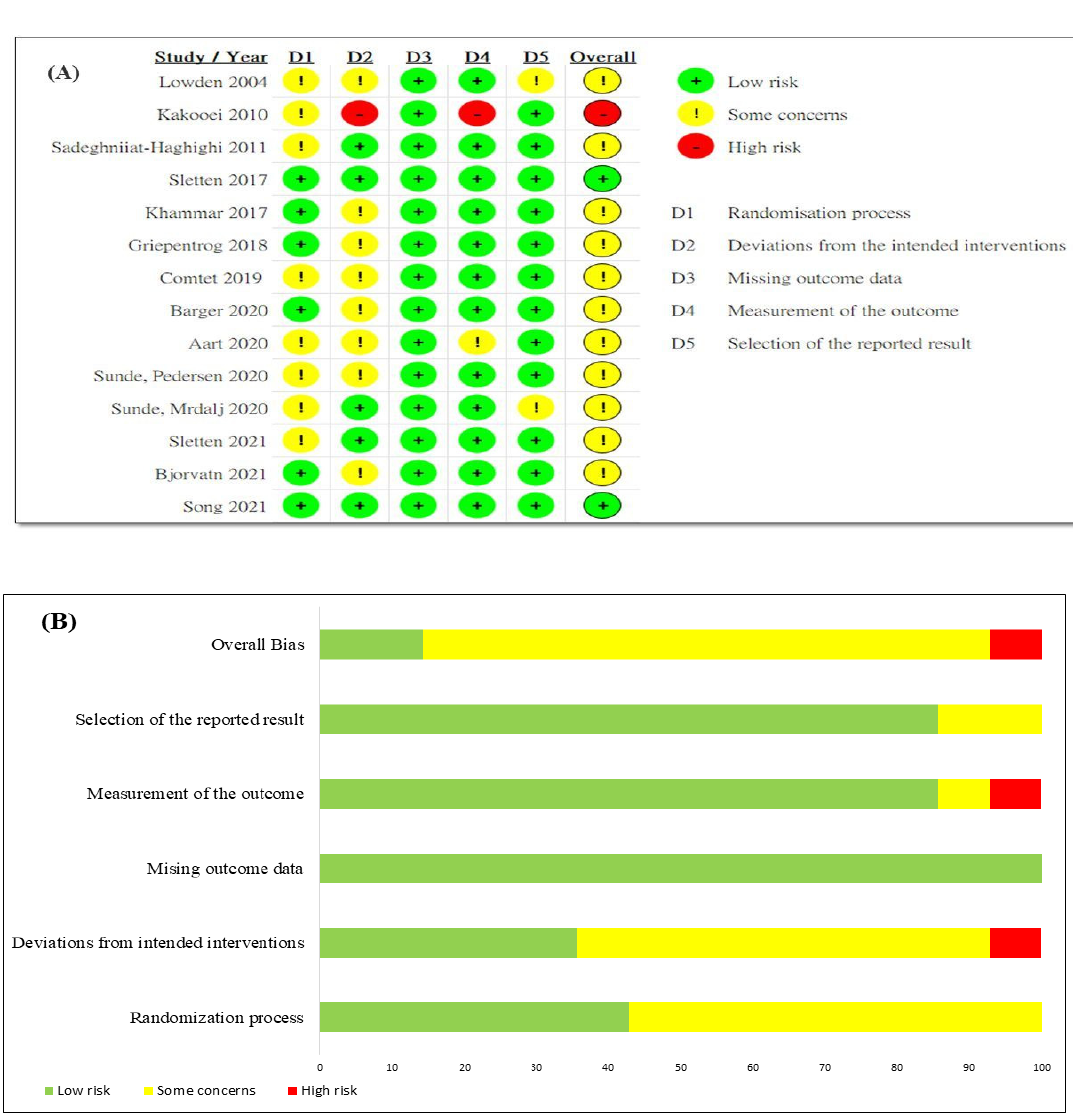
Figure 2. ( A ) Risk of bias summary. ( B ) Risk of bias